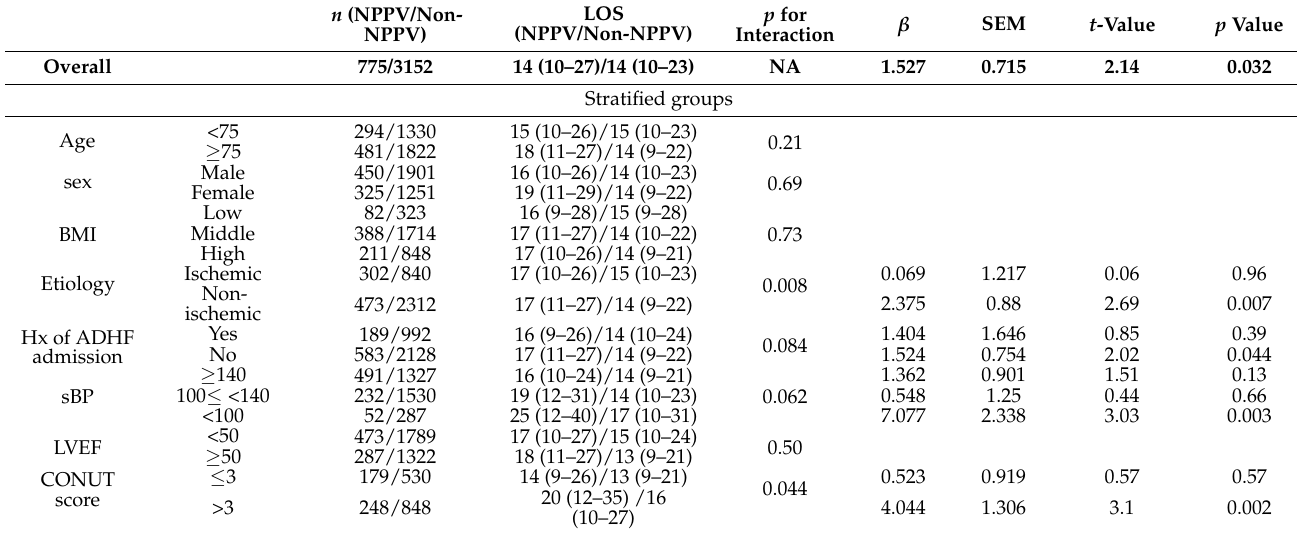
Table 3. Multiple regression analysis for LOS with adjustment for propensity score in the pre-matched overall cohort and stratified